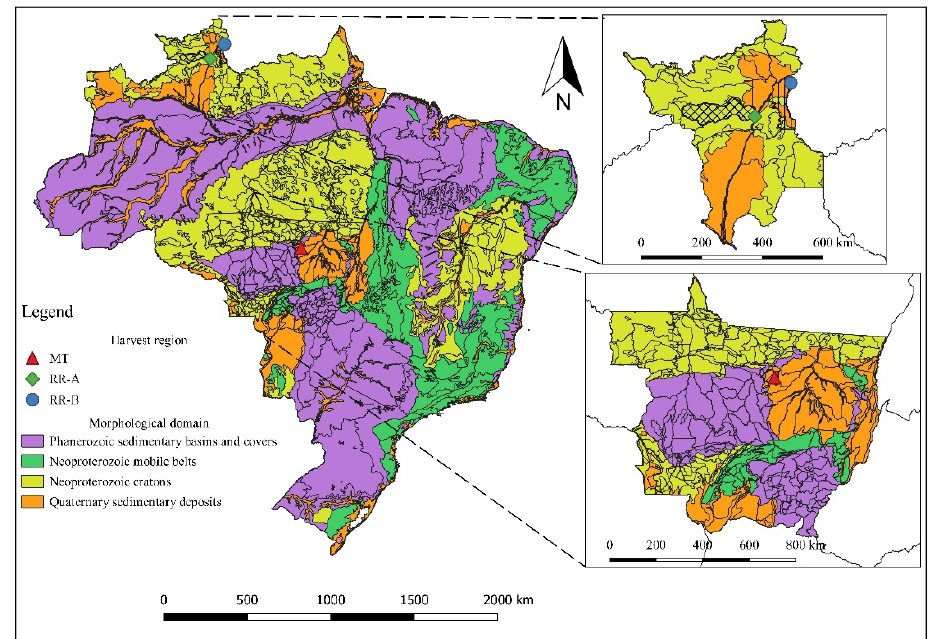
Figure 2. Map of morphostructural domains of harvesting regions.